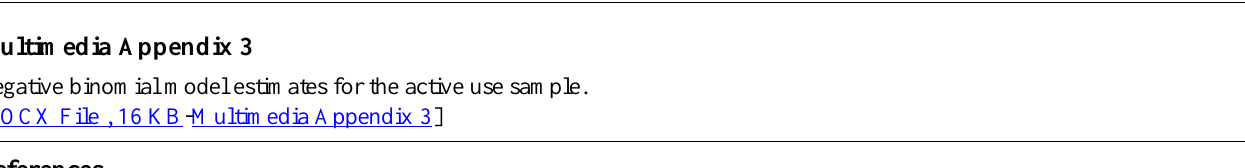
Supplementary Table S2: Linear model estimates with log-transformed alcohol use variables at baseline (independent variable) and 3-month follow-up (dependent variable) for the active use sample